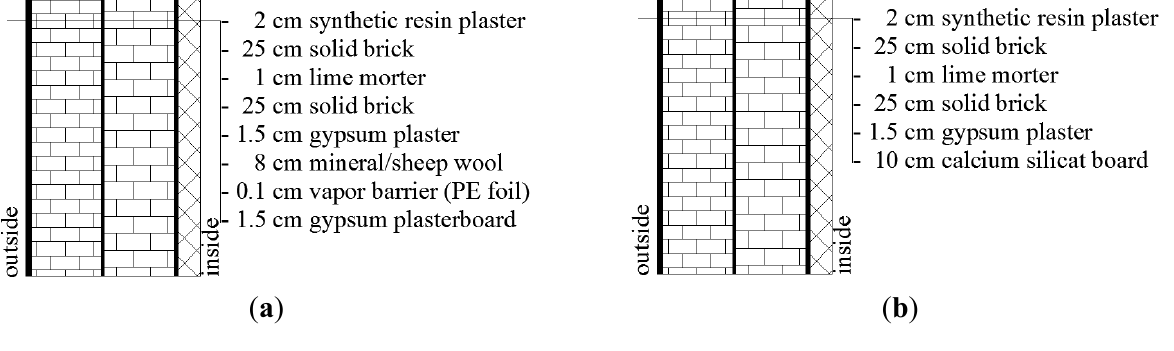
Figure 1. The structure of a common existing wall that was renovated using an interior insulation: ( a ) with wool insulation; ( b ) with calcium silicate